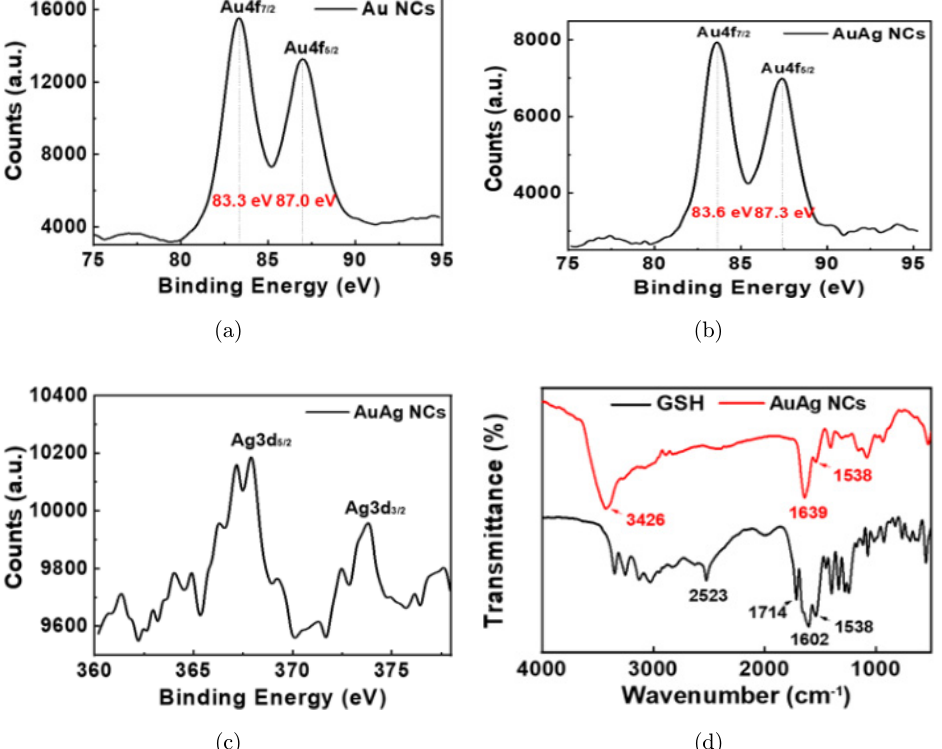
Fig. 3. XPS spectra of (a) Au4f doublet of pure Au NCs and of (b) AuAg NCs, (c) Ag3d doublet of AuAg NCs. (d) FT-IR spectra obtains from pure GSH ligands and AuAg